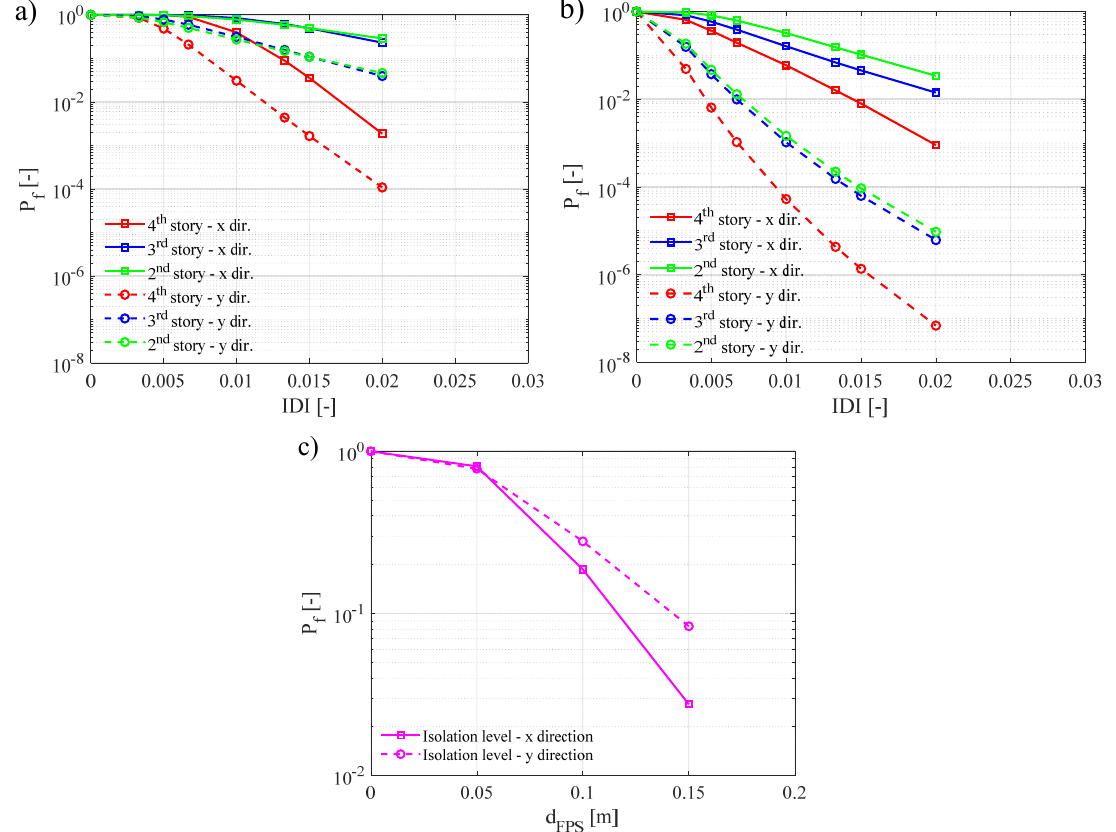
Figure 15. Exceeding monovariate probabilities (logarithmic scale): FB model ( a ); BI model ( b ); Isolation level for BI model ( c ).